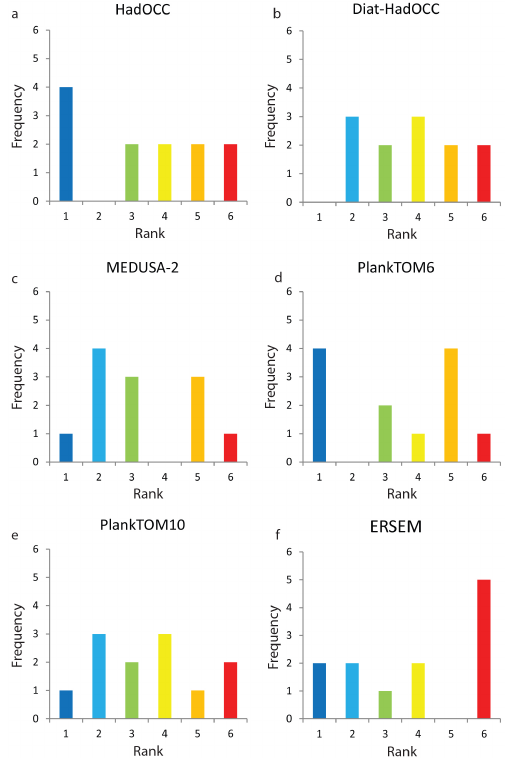
Figure 4. Frequency distributions of best to worst performances for each model in terms of correlation coefficients and normalised stan- dard deviations of annual surface fields and depth integrated pri- mary